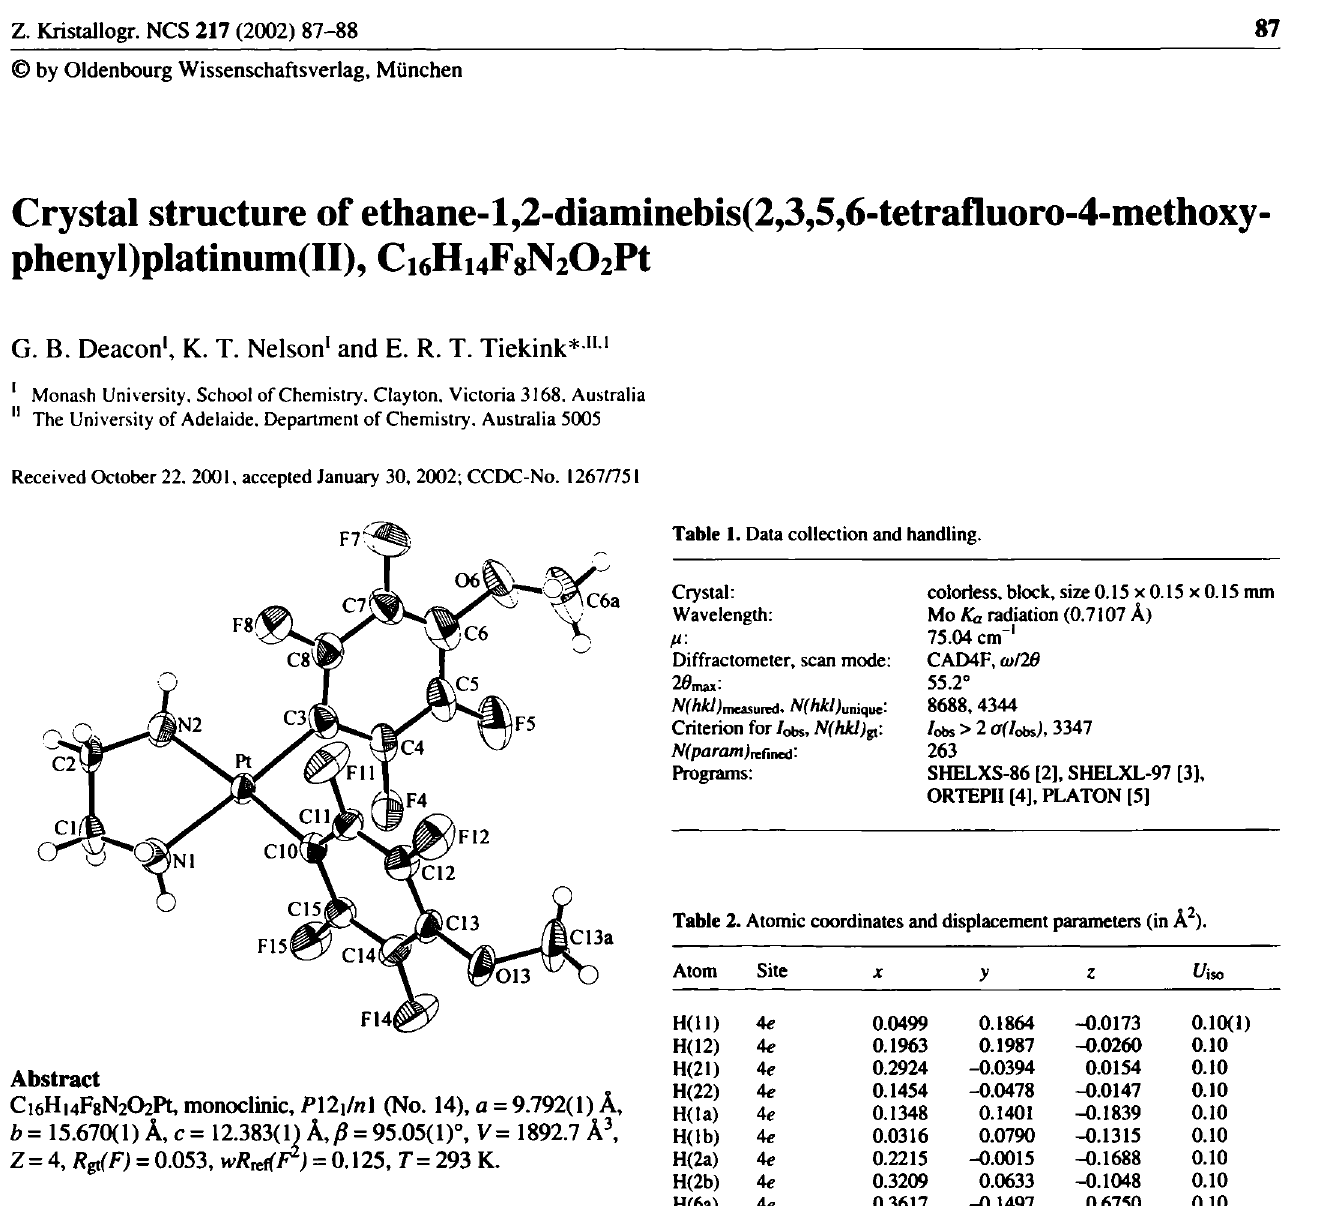
Table 2. Atomic coordinates and displacement parameters (in Â 2